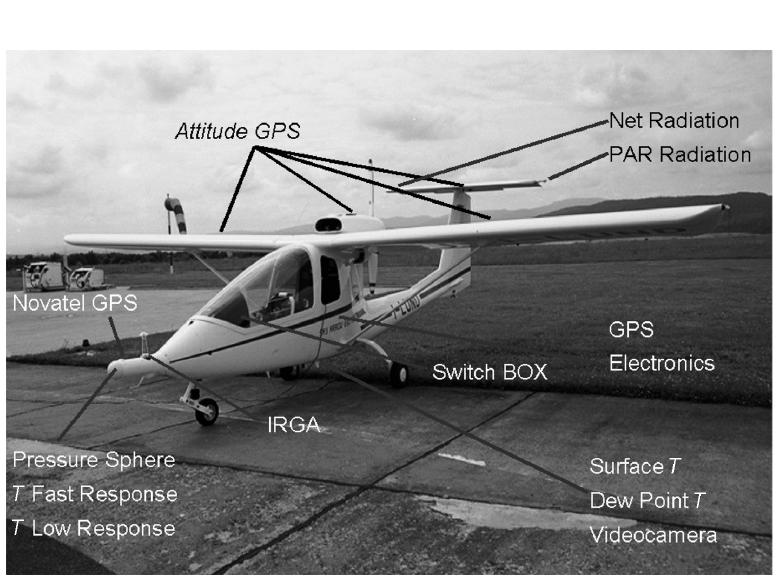
Fig. 1. Photograph of the SkyArrow ERA showing the exact location of the sensors and instruments mounted onboard. The pressure sphere of the BAT probe is visible on the ‘nose’ of the